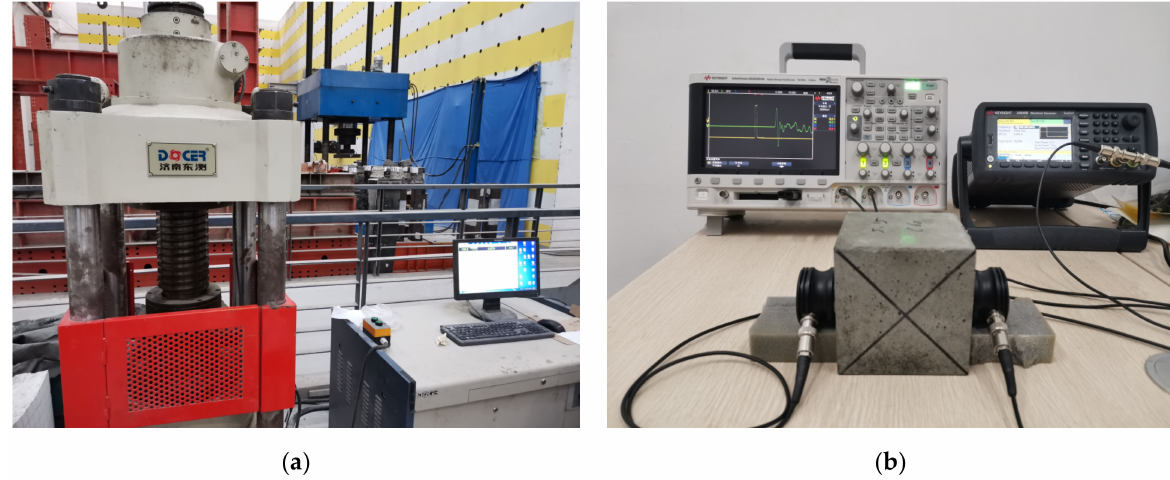
Figure 1. Experimental device: ( a ) electrohydraulics; ( b ) signal generator and oscilloscope.